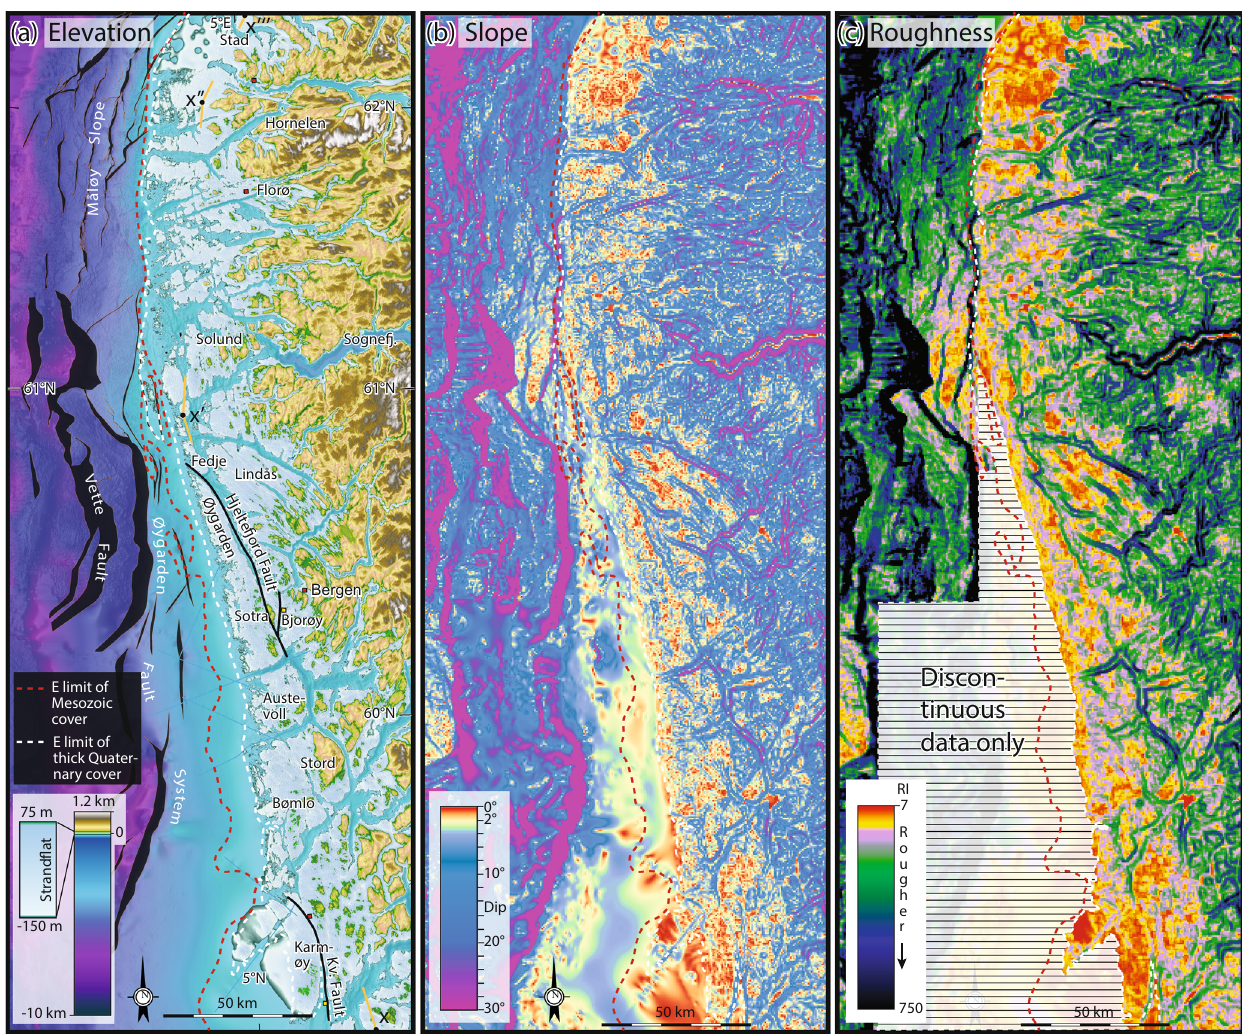
Fig. 2 Maps of the top crystalline basement in the on-offshore study area. The maps were produced by combining onshore topographic data, nearshore bathymetric data and offshore 3D broadband seismic data. a Elevation map of top crystalline basement with the − 150 to + 75 m interval (containing the strand fl at region) marked in light blue. Eastern limits of Mesozoic sediments and of continuous Quaternary cover on basement are shown. b Slope (dip) of the landscape, emphasizing the subhorizontal domain (red color) along the coast that closely correlates with the − 150 to + 75 m elevation interval shown in a . c Terrain roughness (or ruggedness) index (RI) (Riley et al., 1999), showing a low-relief coastal/near-shore region (warm color) that is markedly less rough than the rest of the region and that to a large extent corresponds with the − 150 to + 75 m topographic interval shown in (a). Resolution of original elevation data are 10 m onshore and 50 m offshore, resampled to 250 m before calculation of slope and roughness maps to even out small-scale topographic features. Kv. fault; Kvitsøy